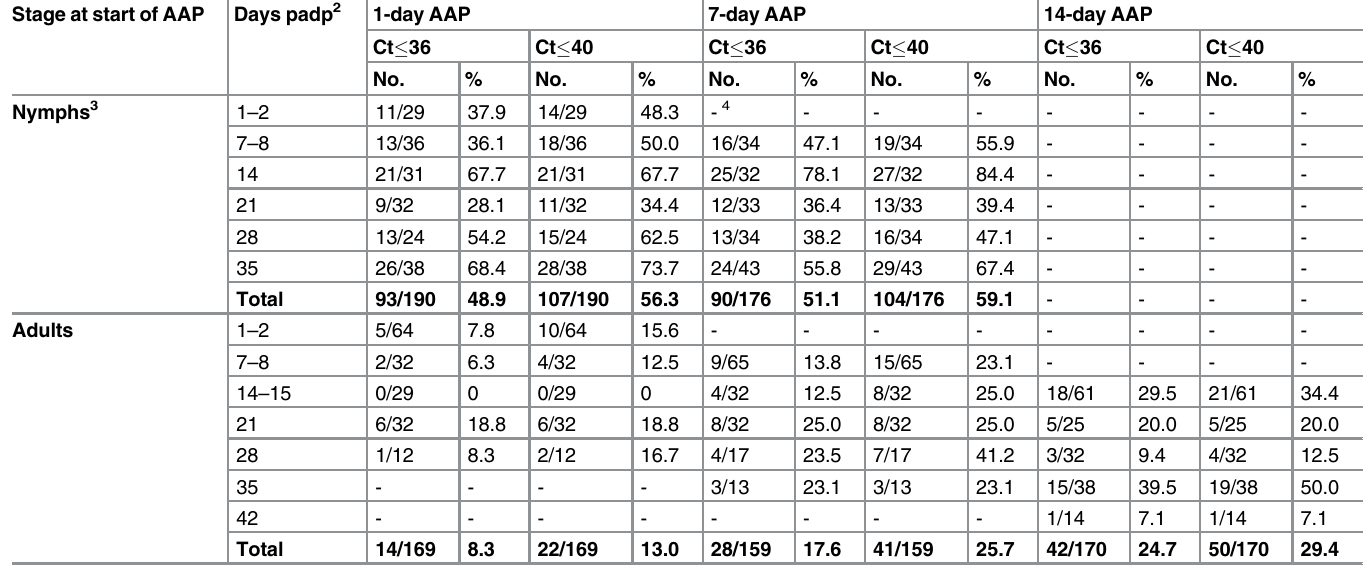
Table 1. Las acquisition by D . citri nymphs and adults: Proportion of Las-infected (qPCR-positive) D . citri that had fed as nymphs or adults on Las- infected citrus plants for an acquisition access period (AAP) of 1, 7 or 14 days then transferred weekly to healthy citrus or orange jasmine seedlings 1 . Stage at start of AAP